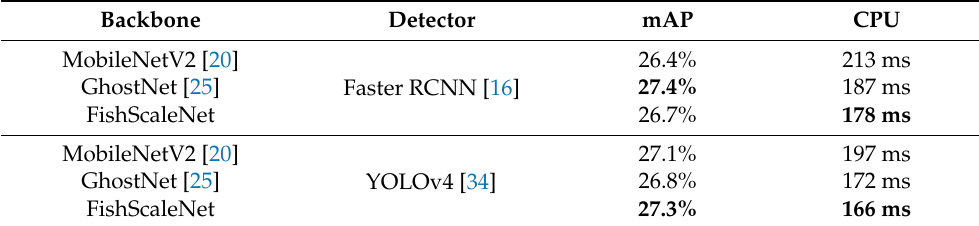
Table 5. Results on MS COCO dataset.